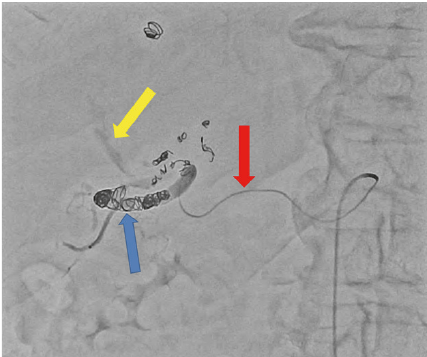
Figure 1: Color Doppler ultrasound demonstrating bidirectional blood flow within an intrahepatic pseudoaneurysm “Ying-Yang sign” (yellow arrow).